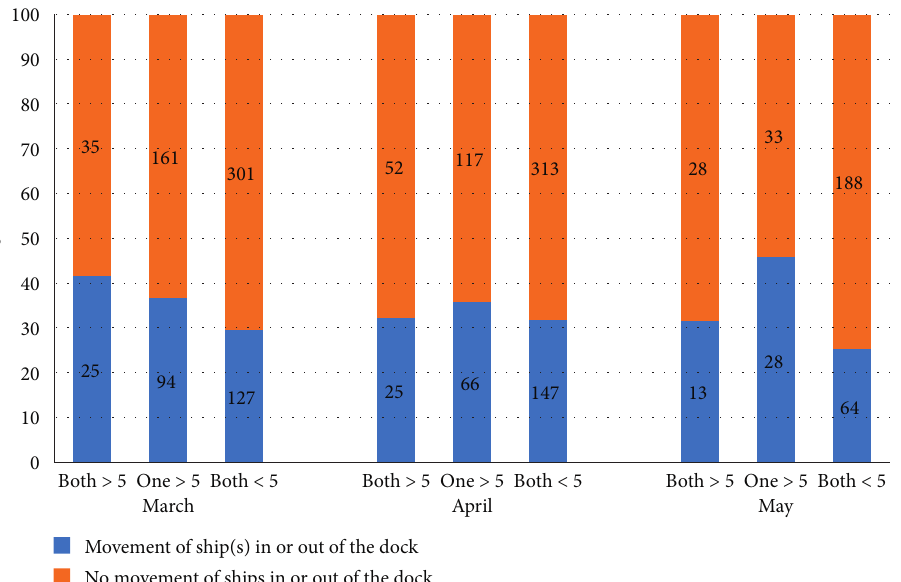
Figure 6: SO 2 concentrations during periods of ship movement in or out of the dock versus periods of no movement of ship(s) in or out of the dock expressed in percentage terms. For each month (March, April, or May), SO 2 concentrations were divided into three categories: SO 2 concentrations at both monitoring points greater than 5 µ g/m 3 (both > 5), SO 2 concentrations greater than 5 µ g/m 3 at only one monitoring station (one > 5), SO 2 concentrations less than 5 µ g/m 3 at both stations (both <